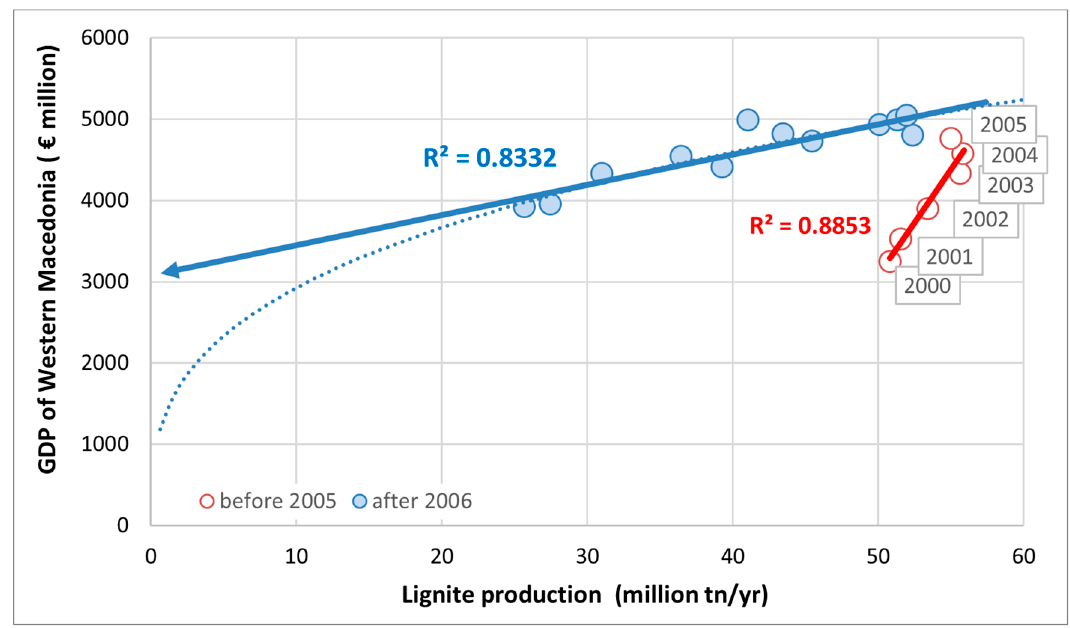
Figure 5. Correlation of GDP of the western Macedonia region and annual lignite production.